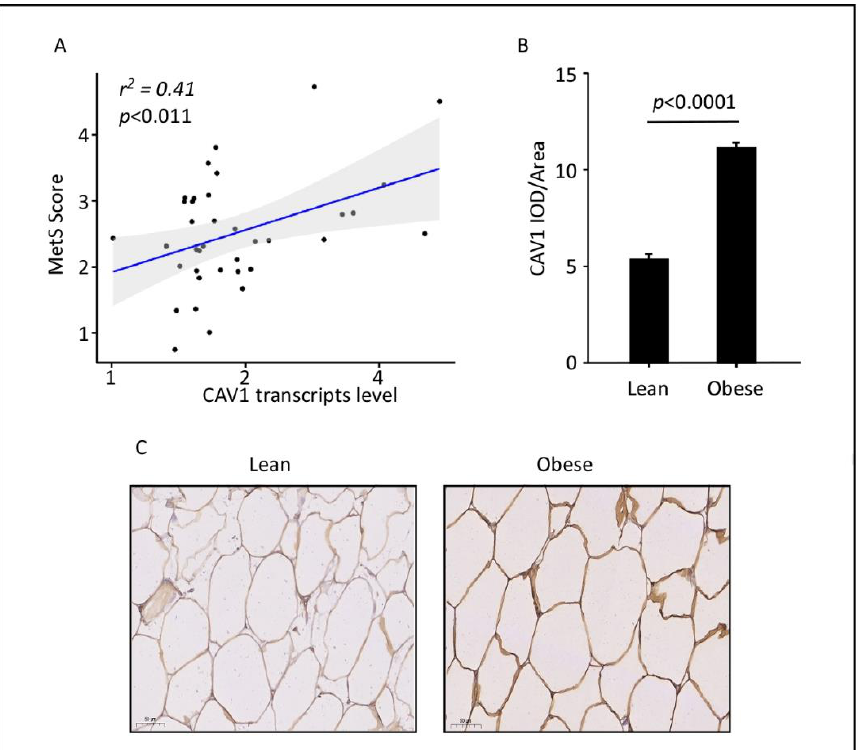
Figure 1. CAV1 transcripts and protein levels in adipose tissues. ( A ) Significant correlation between MetS score and CAV1 transcript levels in the AT of 38 Kuwaiti individuals with varying siMS scores (r 2 = 0.414, p -value < 0.011). ( B ) Integrated optical density (IOD) divided by the adipocyte area was used to quantify CAV1 protein expression in immunohistochemistry (IHC) sections of the adipose tissue samples from lean and obese individuals. The data (mean ± SEM) show significantly elevated levels of CAV1 proteins in subcutaneous ATs from obese versus lean individuals ( p < 0.0001). Five individuals were considered for each of the obese (BMI: >30 Kg/m 2 ) and lean (BMI: <25 Kg/m 2 ) categories. ( C ) Representative immunohistochemistry images (100 × magnification; scale bar 50 µ m). The IHC analysis was performed to determine CAV1 protein expression using five AT sections isolated from five participants per group, each with similar results showing the comparative adipose CAV1 protein expression in lean and obese individuals.